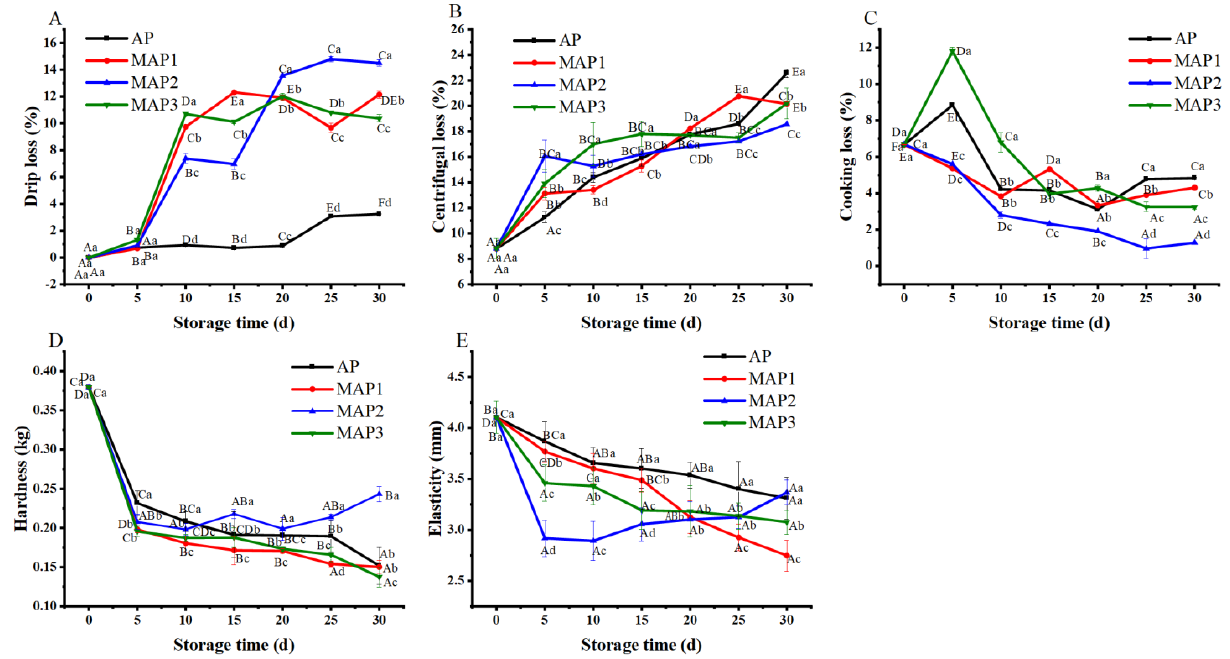
Figure 2. Effect of different gas components packaging on drip loss ( A ), centrifugal loss ( B ), cooking loss ( C ), hardness ( D ) and elasticity ( E ) of golden pompano fillets during storage (−3 °C). Packaging system: AP (control group), MAP1 (30% CO 2 /70% N 2 ), MAP2 (50% CO 2 /50% N 2 ), MAP3 (70% CO 2 /30% N 2 ). Bars indicate the standard error. Different uppercase letters (A–F) indicate significant difference ( p < 0.05) in means (n = 3) between display times within the same packaging system; different lowercase letters (a–d) indicate significant difference ( p < 0.05) in means (n = 3) between packaging systems on the same